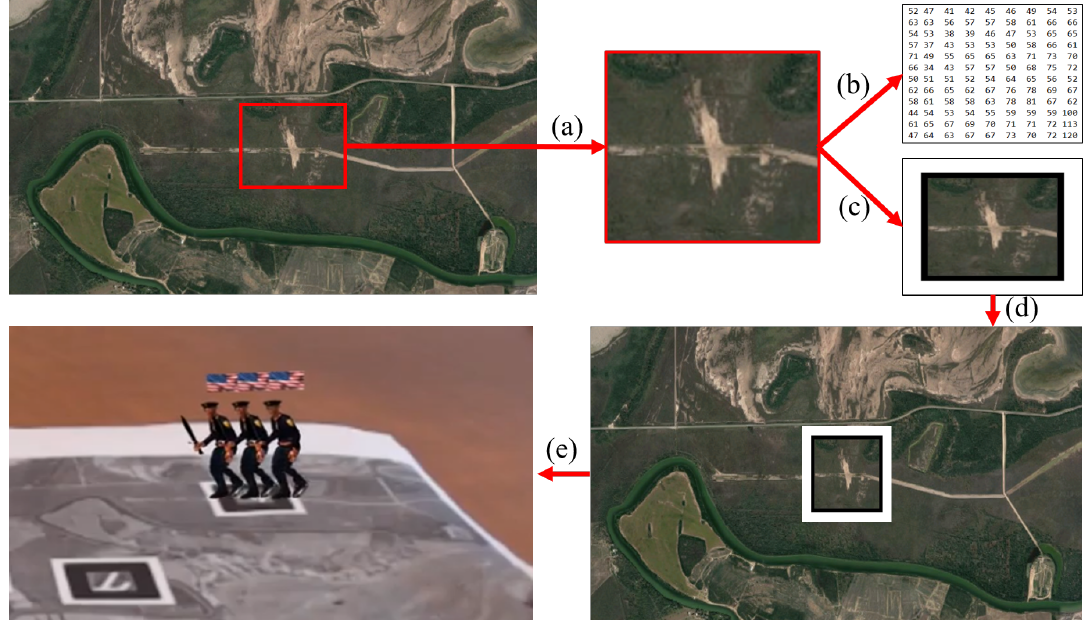
Figure 5. Process of creating marker and embedding onto existing map: ( a ) cropping region of interest, ( b ) extract sample templates, ( c ) augmented black square box, ( d ) append image back to the map and ( e ) superimpose 3D model on the